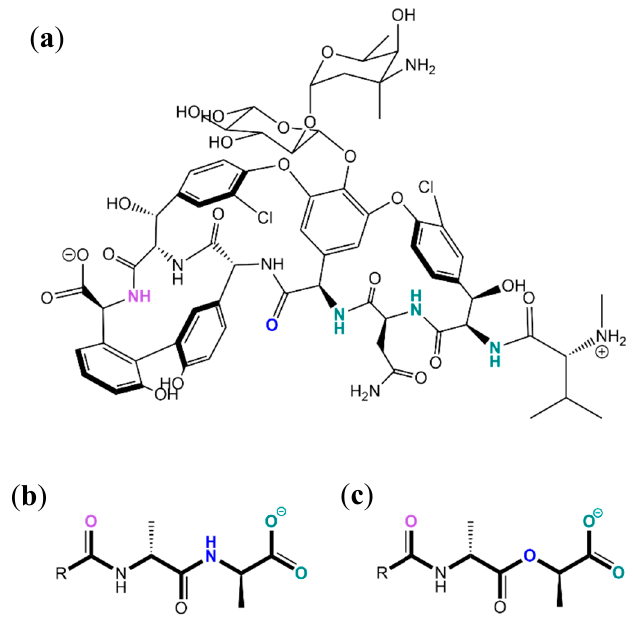
Figure 26. ( a ) Vancomycin, ( b ) its target sequence in the cell wall of gram positive bacteria, D -Ala- D -Ala-OH and ( c ) the mutated sequence, D -Ala- D -Lac-OH. The sites in vancomycin highlighted in pink, blue and green interact with the same colored groups in the sequences. In the mutated sequence, one of the hydrogen bonds is broken and there is instead electrostatic repulsion between the groups in blue [6].